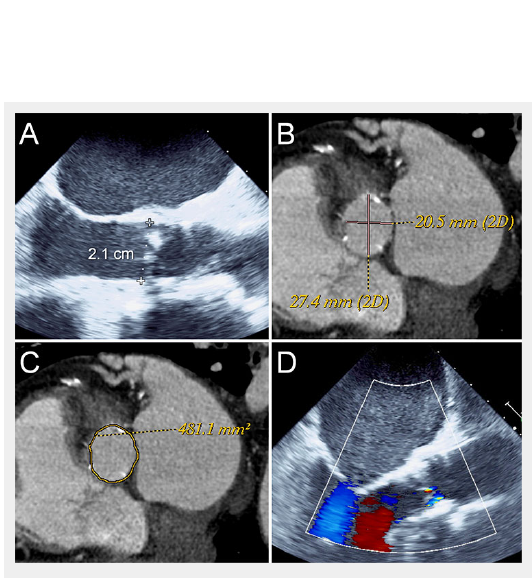
Annulus sizing using TEE and CT angiography. TEE measured an annulus of 2.1 cm suggesting a 23 mm Edwards Sapien or a 26 mm Medtronic CoreValve (A). CT angiography measured an area of 481 mm2 (C) and a mean diameter of 24 mm (B) suggesting a 26 mm Edwards Sapien or a 29 mm Medtronic CoreValve valve with ~10% oversizing. A 26 mm Edwards Sapien valve was implanted with trace paravalvular leak (D).